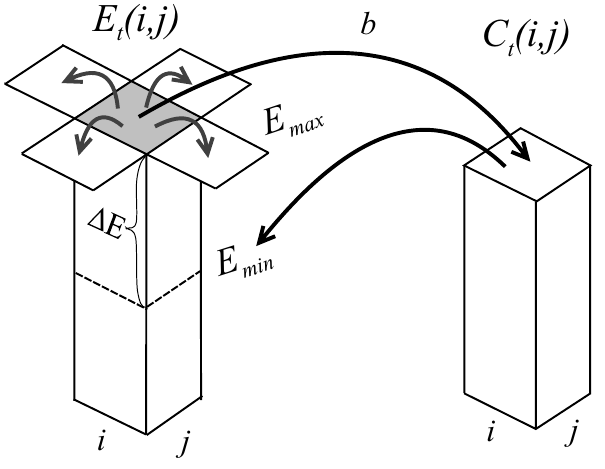
Fig. 2. Scheme of the local positive feedback between “magneto- spheric” and “ionospheric” parts of a cell: E t (i,j) -stored energy, C t (i,j) -ionospheric